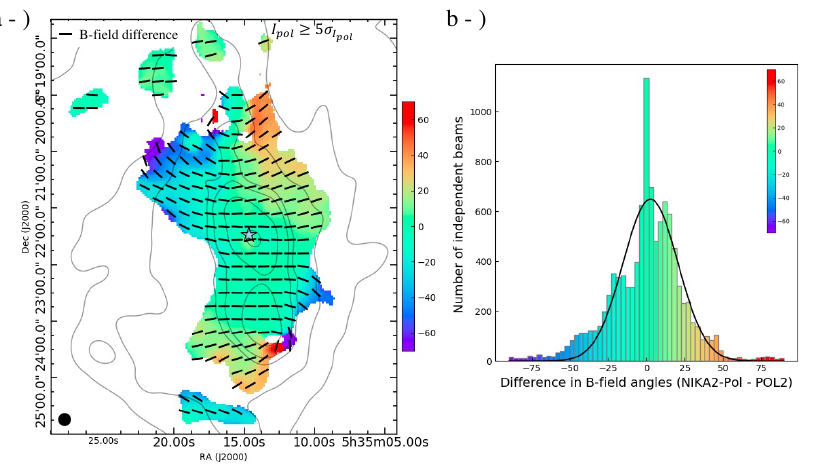
Figure 2. Di ff erences in B-field angle between NIKA2-Pol and POL2 data in OMC-1 at the same angular resolution (14 ′′ ) and for positions with high signal-to-noise ratio in polarized intensity ( I pol > 5 σ I for both NIKA2-Pol and POL2). a-) : Map of the di ff erences in B-field angle (NIKA2-Pol pol − POL2). The overlaid black segments display di ff erence vectors plotted every 14 ′′ beam. b-) : Histogram of the di ff erences in B-field angle (NIKA2-Pol POL2). The amplitude of the di ff erence in B-field − angle between NIKA2-Pol and POL2 is less than 10 ◦ for 67% of the